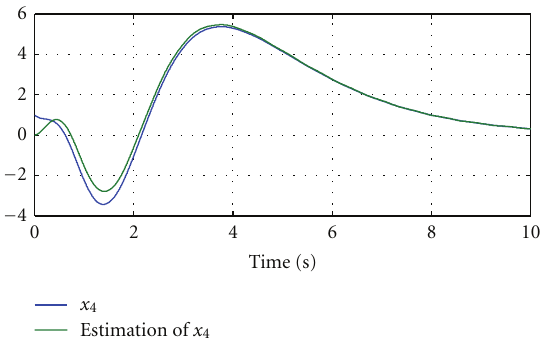
Figure 1: True and estimation values of x 4 for Example 5.